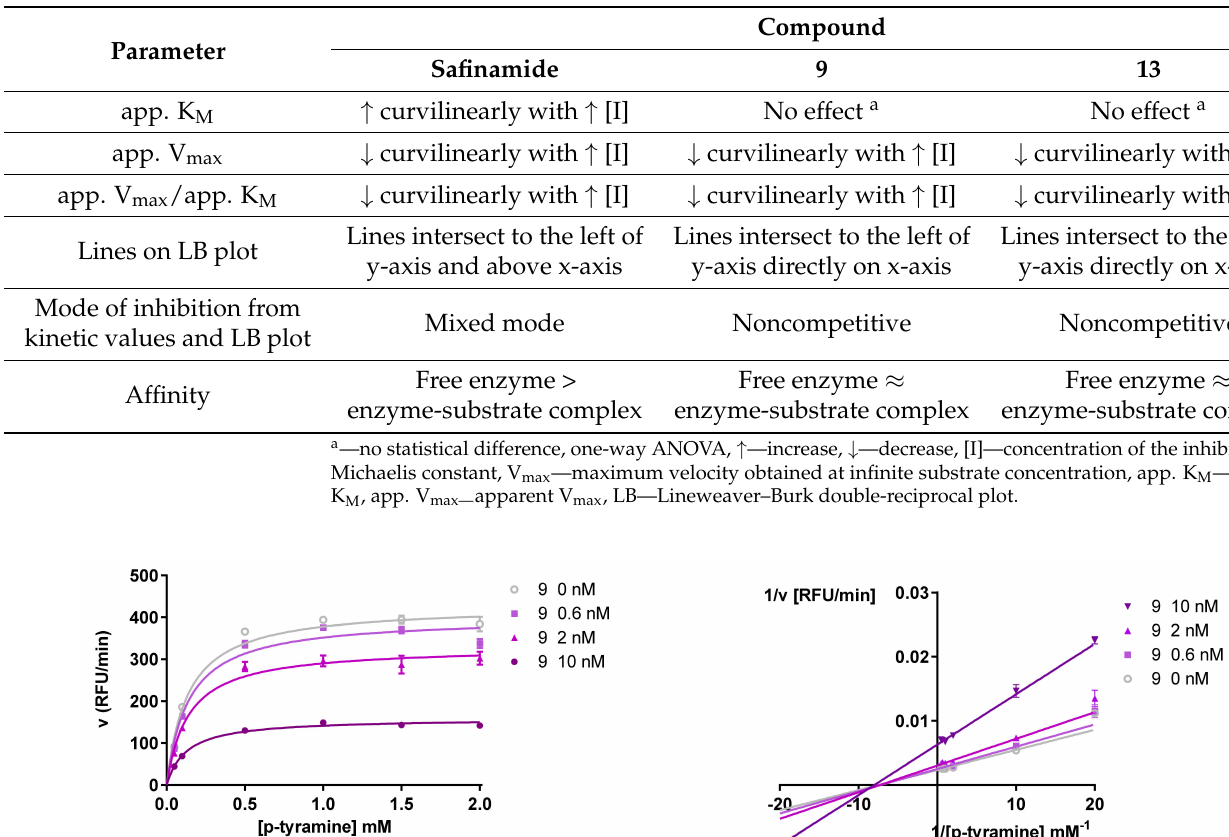
Table 5. Effects of inhibition modalities on steady state kinetic parameters and diagnostic signatures on double-reciprocal Lineweaver–Burk plot of safinamide, 9 and 13 .